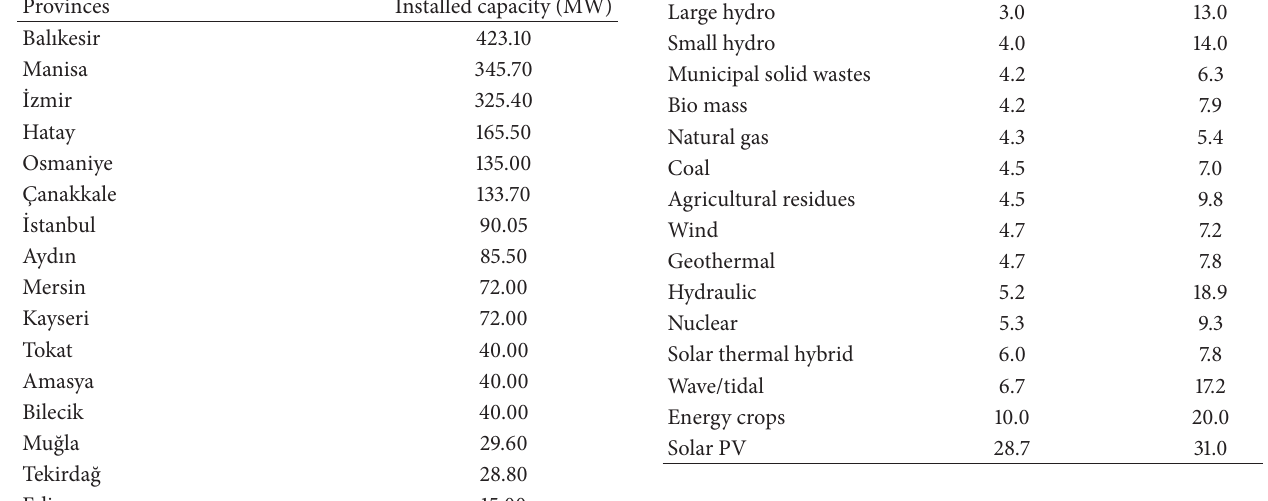
Table 7: Cost structure of a typical 2MW wind turbine installed in Europe